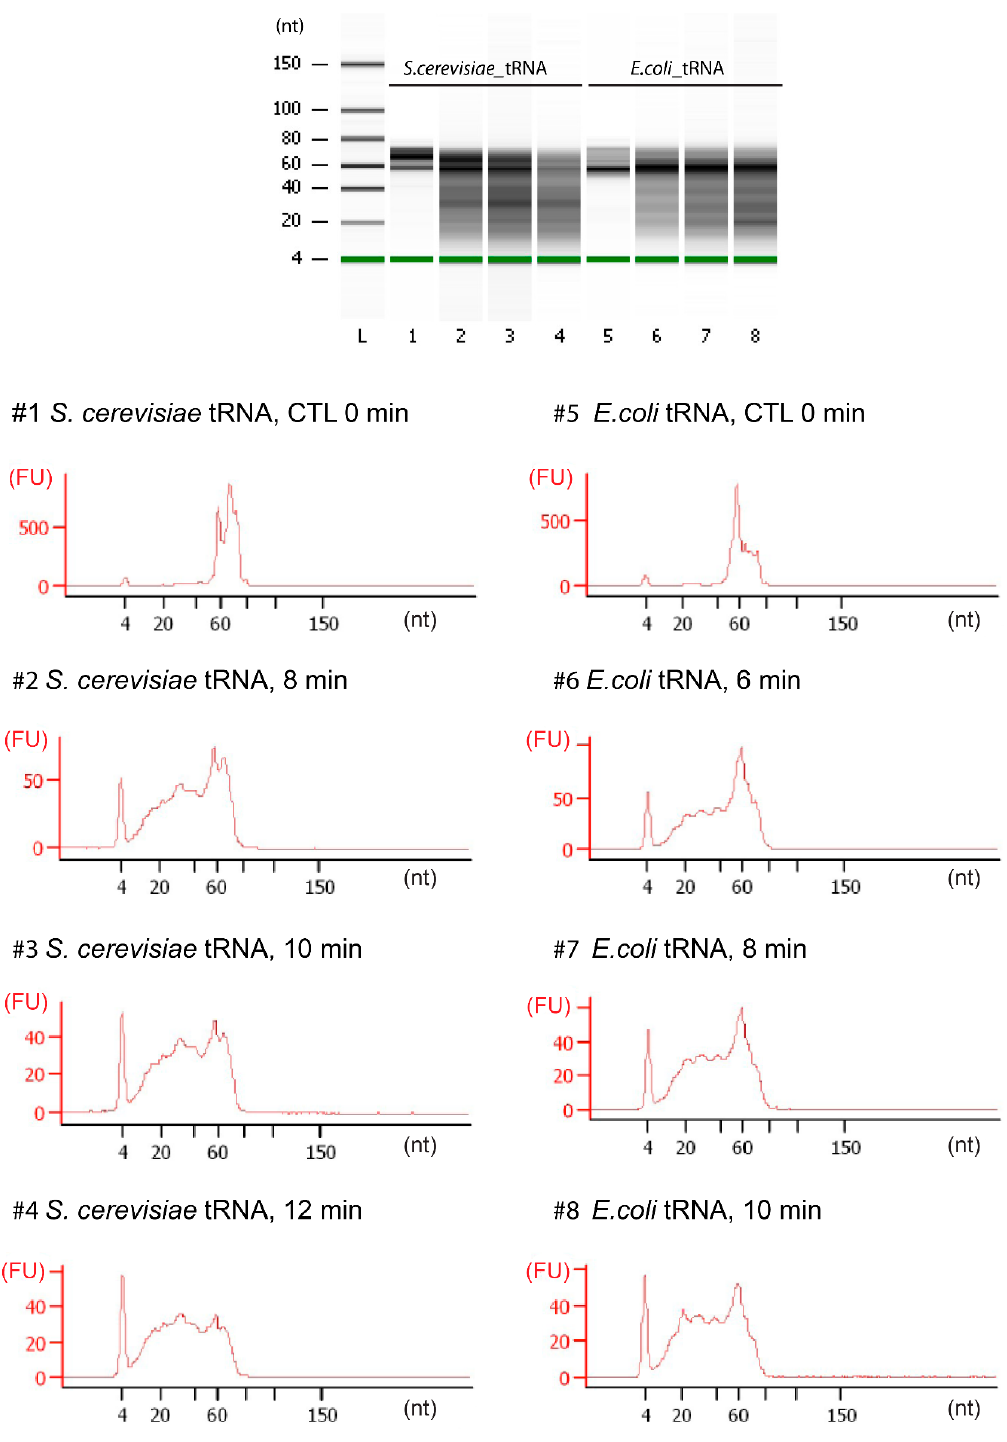
Figure 2. Fragmentation profiles for E. coli and S. cerevisiae total tRNA fractions. Alkaline hydrolysis was performed for 6–12 min (as indicated on the traces). Fragments size was analyzed by capillary electrophoresis on a Bioanalyzer 2100 (Agilent, Santa Clara, CA, USA) Small RNA Chip. FU: fluorescence unit.